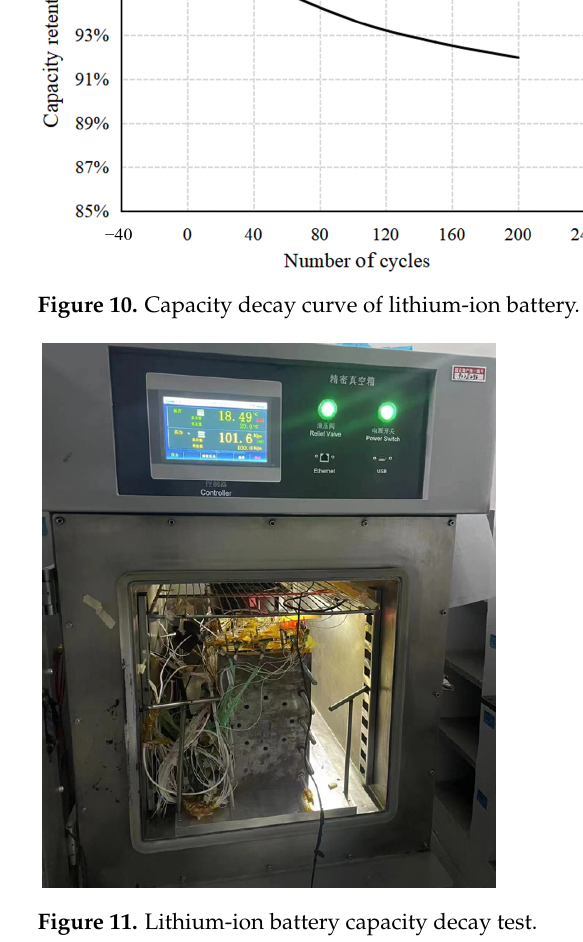
Table 5. Dynamic system